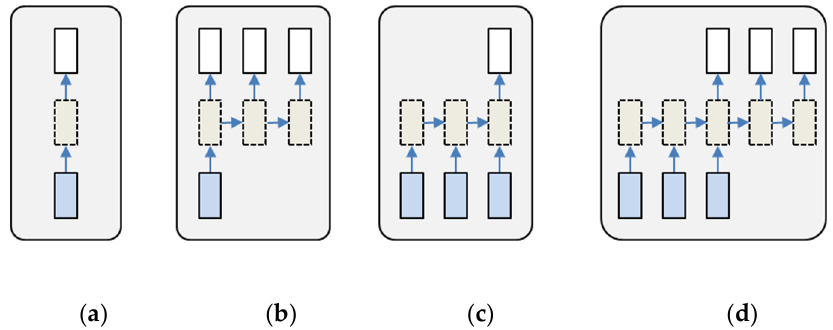
Figure 2. Various architecture of RNN models: ( a ) one-to-one; ( b ) one-to-many; ( c ) many-to-one; ( d ) many-to-many.